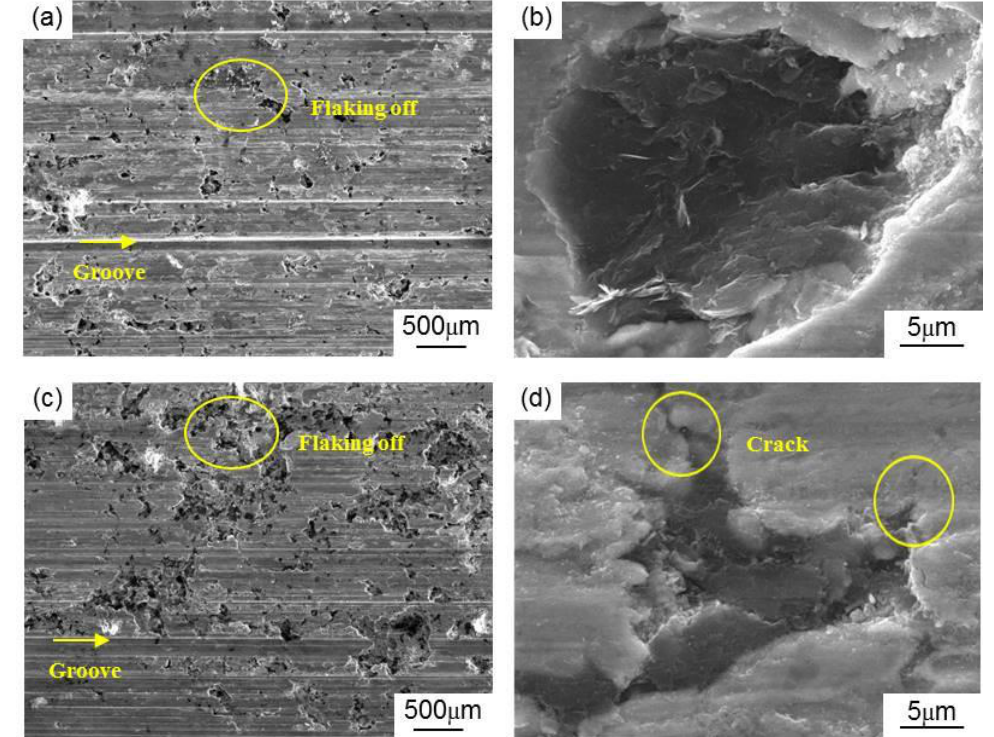
Figure 11. Wear surface morphologies of the ( a , b ) MCMB–Cu composites and ( c , d ) GrF–Cu composites.